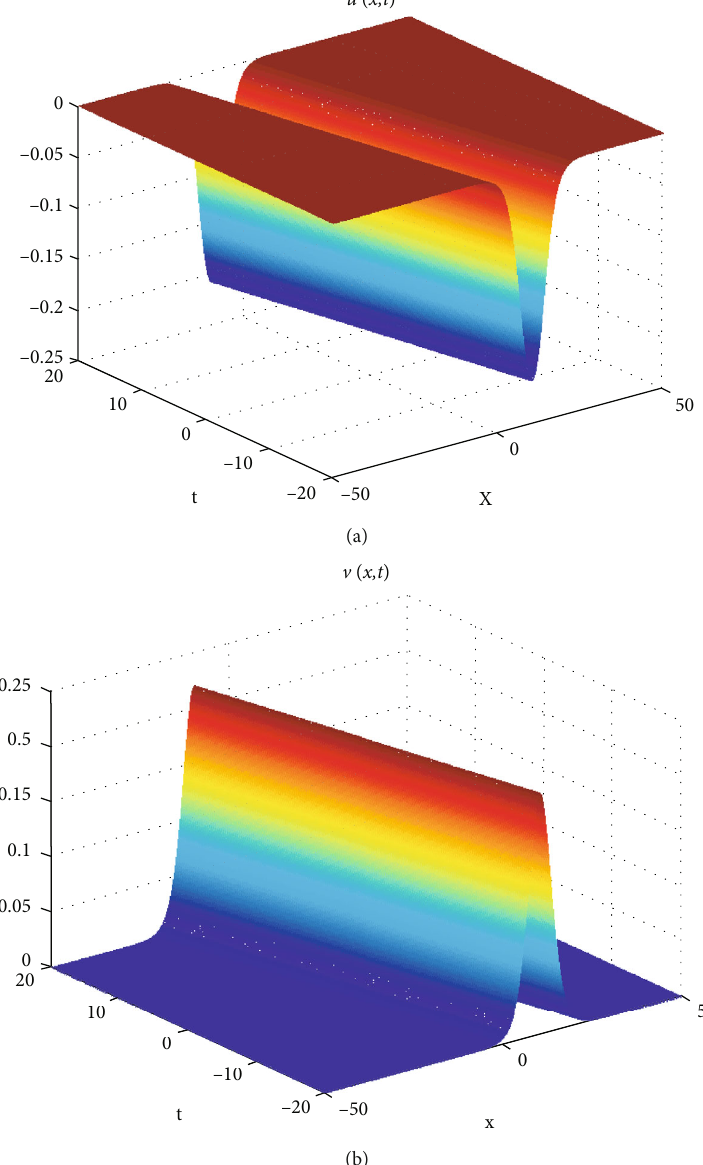
Figure 1: Time and space evolution of the antibell soliton solution u ð x , t Þ and bell soliton solution v ð x , t Þ in Equation (16) for parameters k 1 = 1/2, α = 1 . (a) u ð x , t Þ . (b) v ð x , t Þ